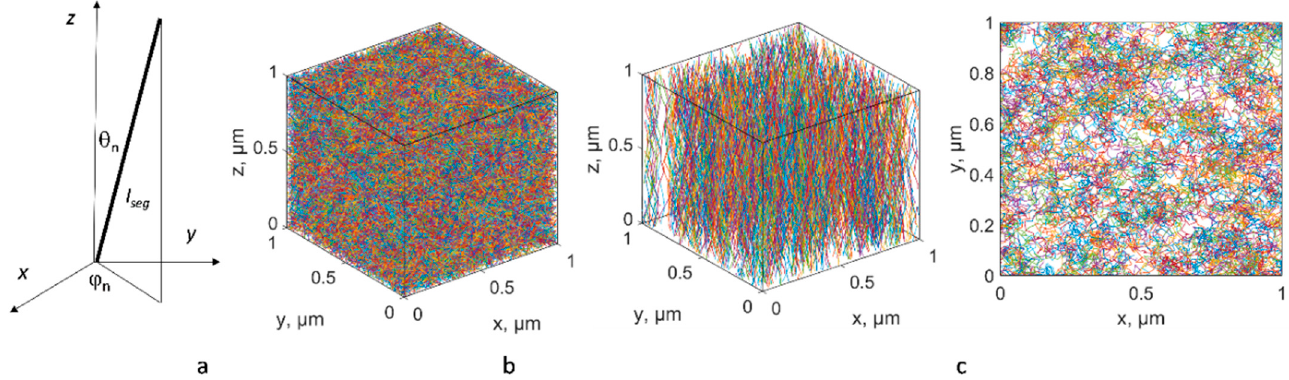
Figure 2. Geometrical model: ( a ) parameters of a CNT segment; central paths of CNTs in ( b ) RVE for R-SW, VF = 1%; ( c ) RVE for A-MW; VF = 7%, 3D view ( left ) and view from the end of the Z -axis ( right ).